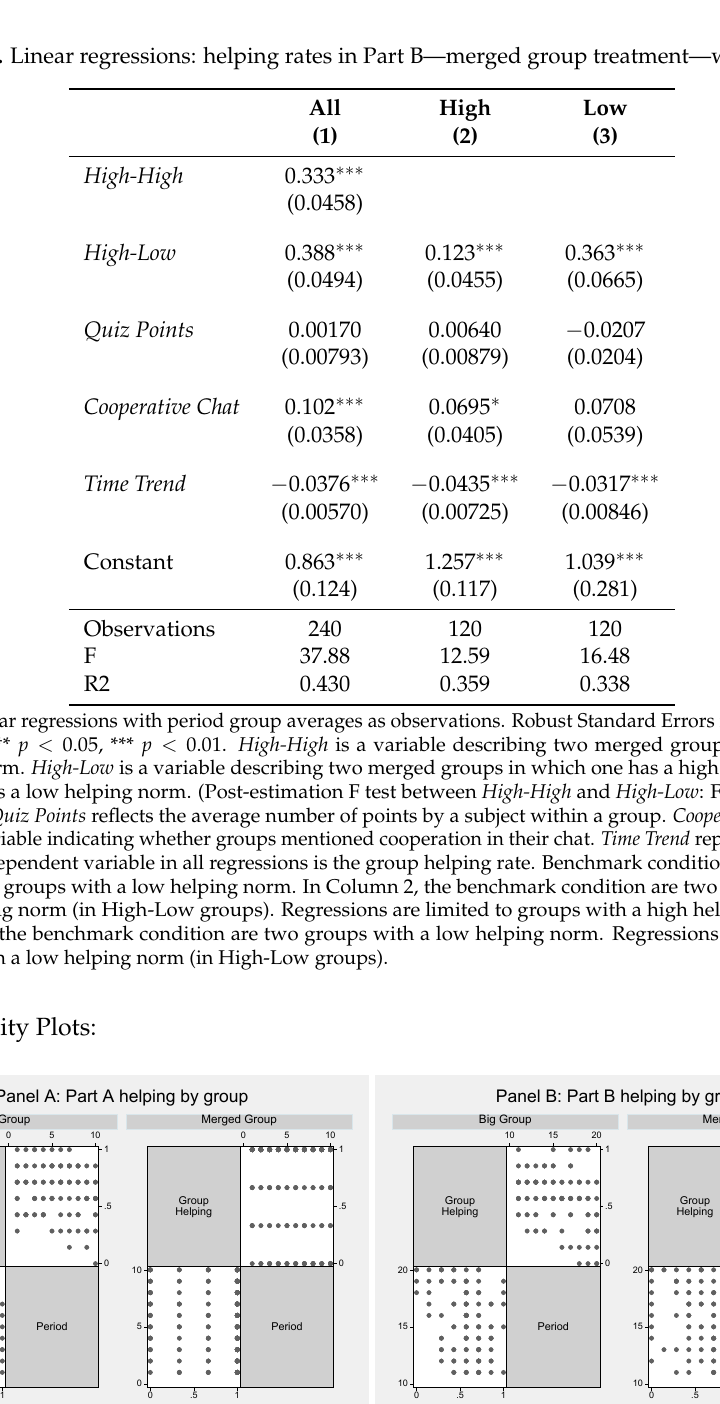
Figure A3. Mean helping rates in Part A and Part